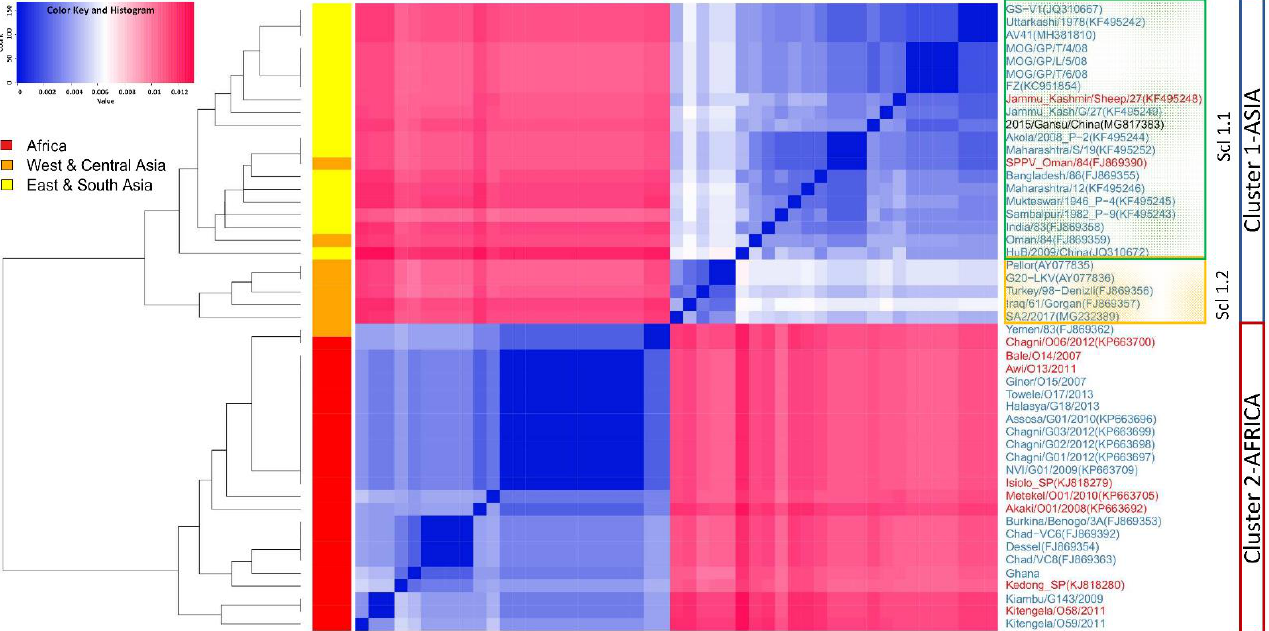
Figure 2. The heatmap for the nucleotides k-mers frequencies variations of 49 GTPVs. The Complete-linkage clustering method was used to re-order the sequences. The vertical side colors indicate the origin of the samples (red for Africa, orange for West and Central Asia, yellow for East and South Asia). The GTPVs recovered from goats are shown in blue, those from sheep in red and those with unknown host in black. The clusters and sub-clusters (Scl) are indicated with boxes.